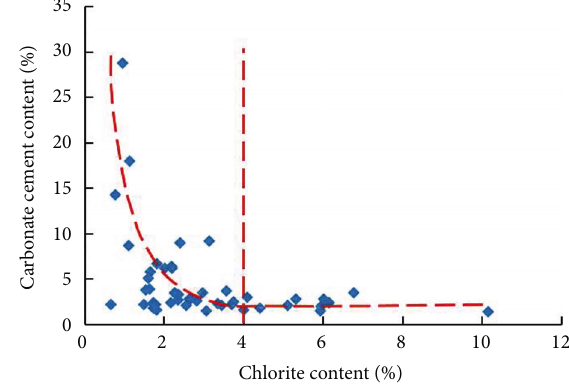
Figure 9: The relationship between chlorite content and carbonate cement content in the study